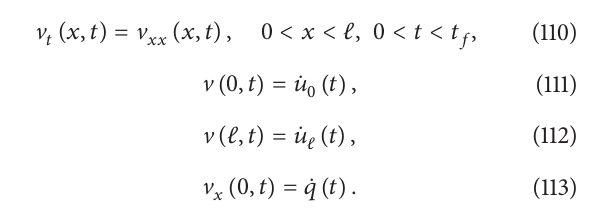
Figure6:Example5showing(a)residualandsteplengthofOGSDA, (b) comparing numerical and exact solutions, and (c) numerical errors of OGSDA, GMRES, and BBM.